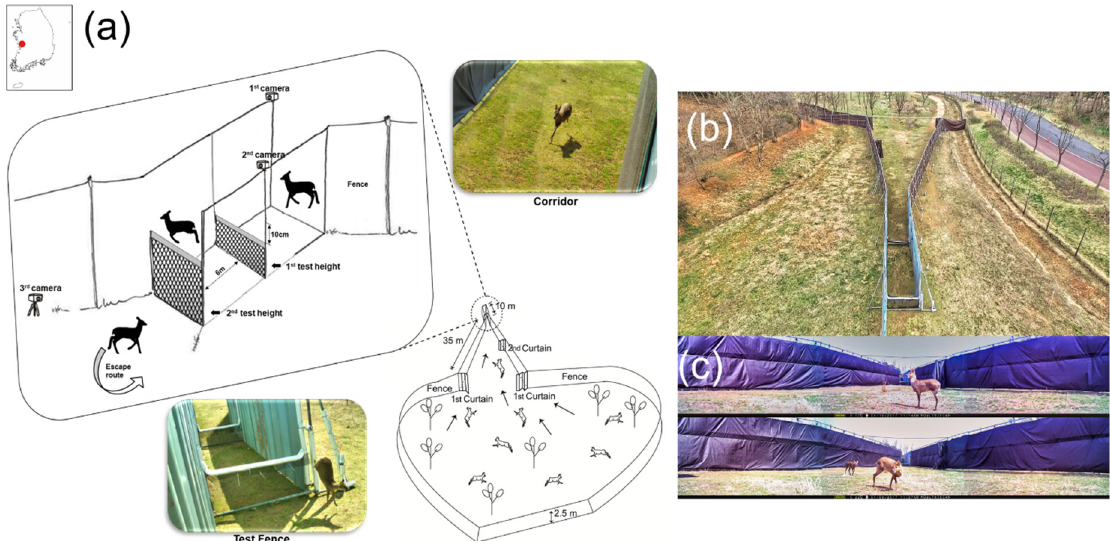
Figure 1. ( a ) Location and diagram of the facility in the deer park. The left upper inset is the enlarged diagram of the test fence area. Two pictures show the water deer in the corridor and test fence. ( b ) Pictures of the capture-jumping test experimental facility (CJEF) and ( c ) water deer in the CJEF.